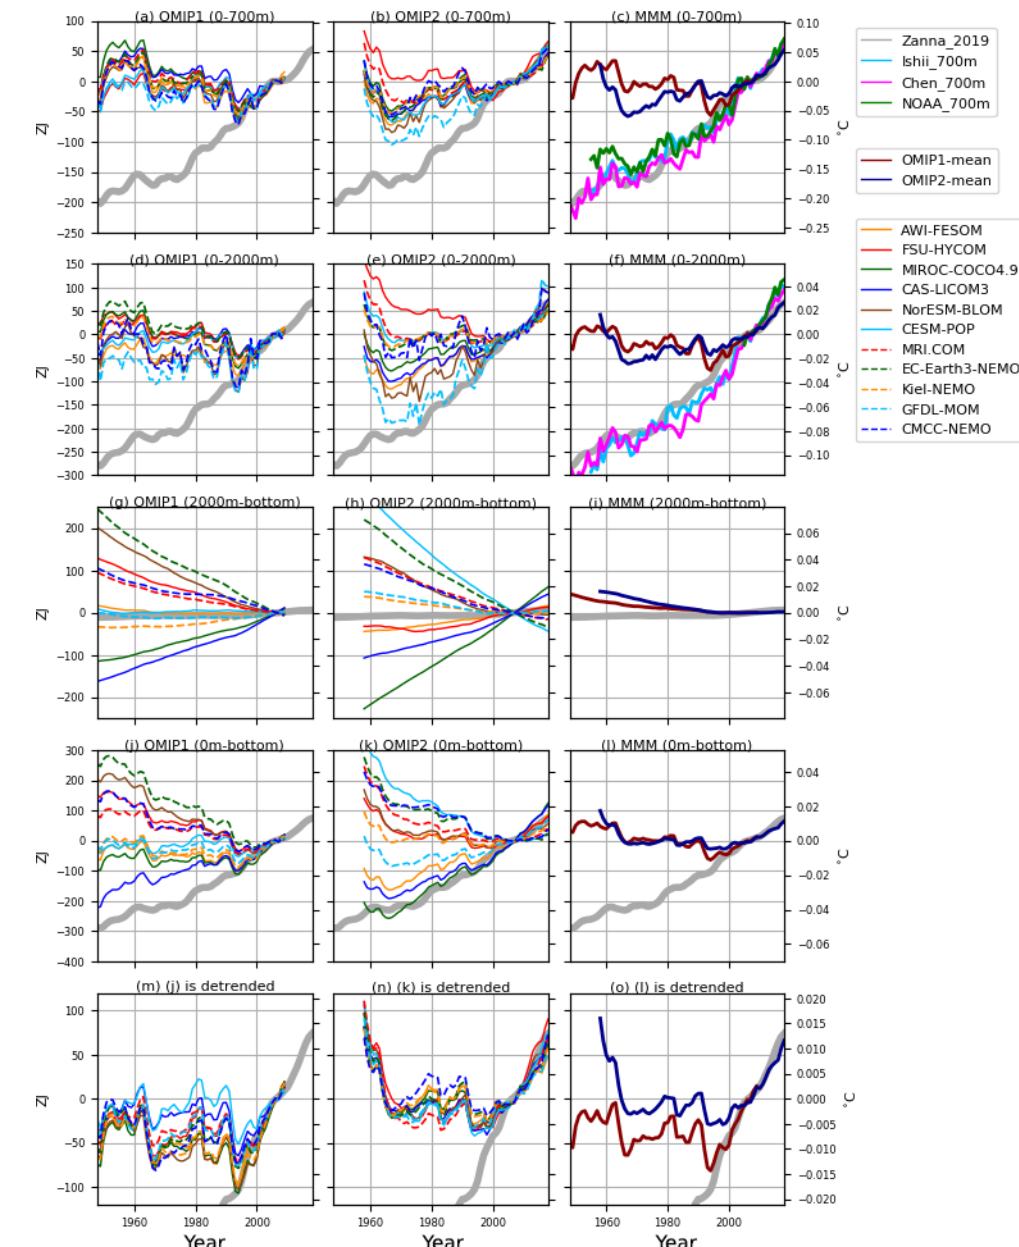
Figure 24. Time series of annual mean globally integrated ocean heat content anomaly (ZJ = 10 21 J) in several depth ranges relative to the 2005–2009 mean: (a–c) 0–700m, (d–f) 0–2000m, (g–i) 2000m–bottom, (j–l) 0m–bottom, and (m–o) 0m–bottom detrended. (a, d, g, j, m) OMIP-1, (b, e, h, k, n) OMIP-2, (c, f, i, l, o) multi-model ensemble mean of OMIP-1 (red) and OMIP-2 (blue). Note that heat content anomalies from models are calculated by multiplying volume (based on valid points of the WOA13v2 dataset), specific heat (3990Jkg − 1 ◦ C − 1 ), and density of seawater (1036kgm − 3 ) to vertically averaged temperatures ( ◦ C). Temperature scales are written on the righthand side of vertical axes. Observational estimates are due to Zanna et al. (2019) (grey lines) for all panels, and Ishii et al. (2017) (light blue lines), Cheng et al. (2017) (magenta lines), and Levitus et al. (2012) (green lines) for the multi-model mean panels (the right column) if they are